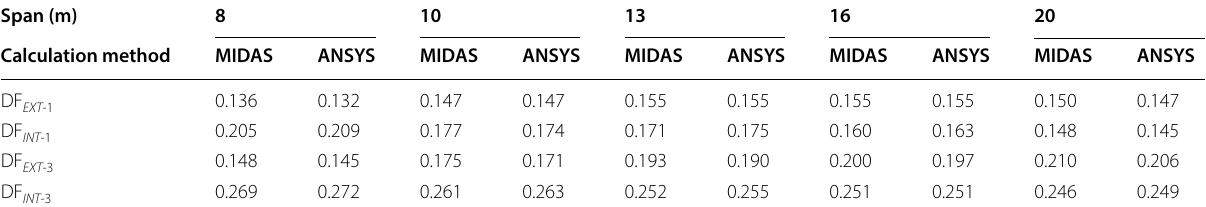
Table 4 DFs for span parameter in the FEM.